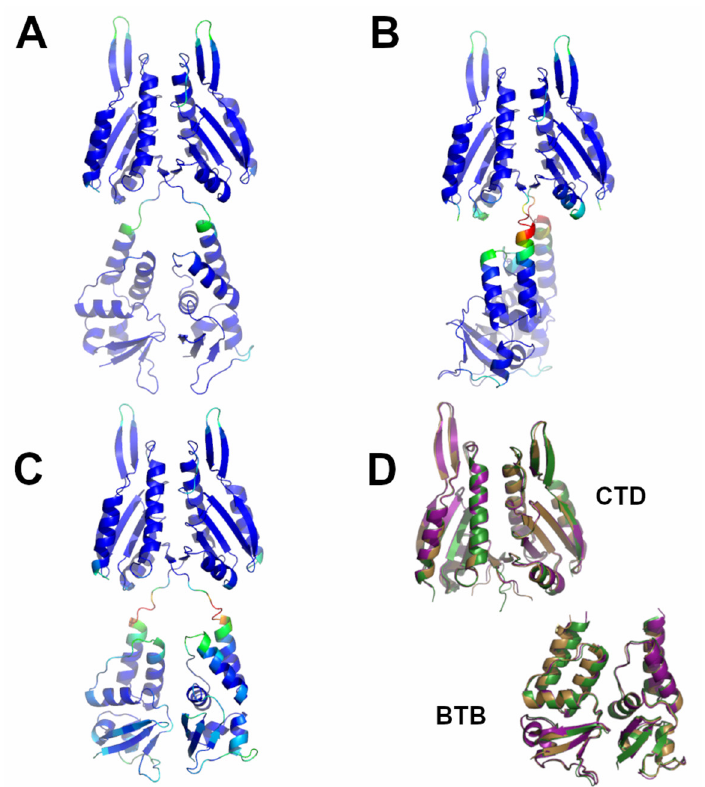
Figure 8. Schematic representation of AF full-length structures of members of Cluster 6. ( A ) KCTD10; ( B ) KCTD13; ( C ) TNFAIP1; ( D ) superimposed CTD and BTB domains (KCTD10 in purple; KCTD13 in dark green; TNFAIP1 in sand). Structural models in panels A-C are colored following AF per-residue confidence metric (pLDDT).